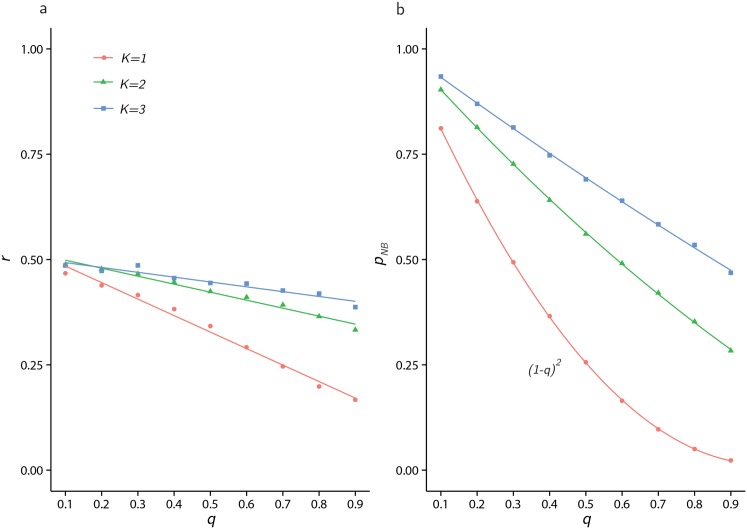
Extracting negative binomial parameters.When approximating the distribution of cascade sizes with a negative binomial distribution with parameters r and pNB, the parameters of moment matched negative binomial distributions are presented as a function of q, for K = 1, 2, 3. a) r and b) pNB.